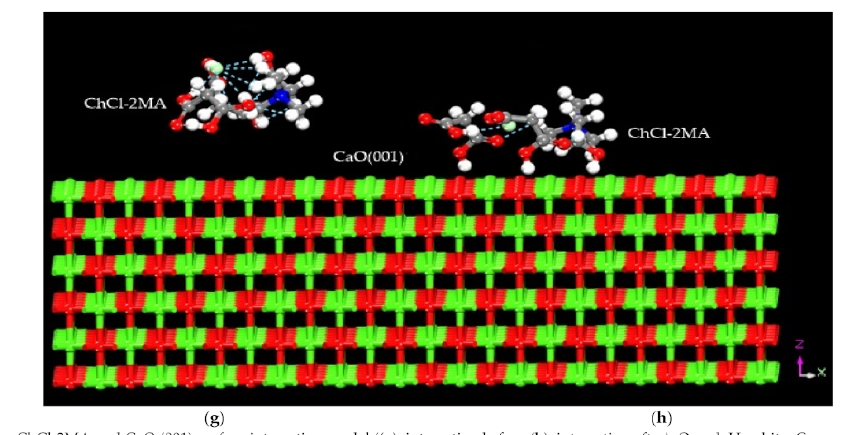
Figure 5. Interaction models of different metal oxides and